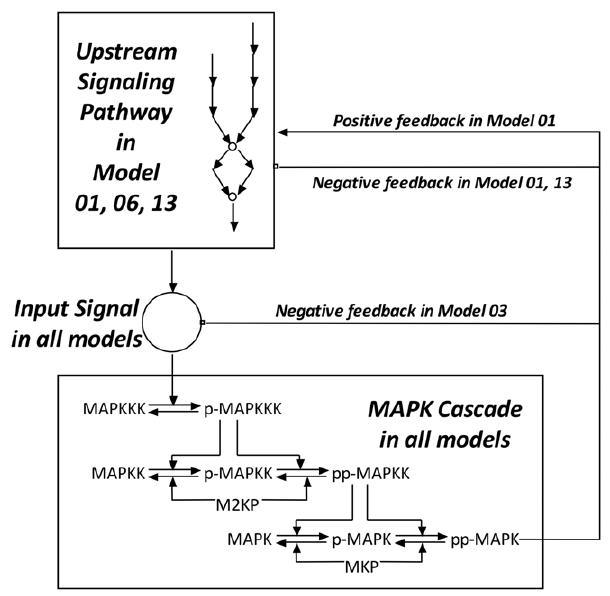
Figure 1. A schematic drawing summarizing the topologies of the MAPK activation network studied by previous models. The numbers are numeric IDs of the models as they are referred in the text and Table 1. The prefix ‘p-’ means phosphorylated and ‘pp-’ means